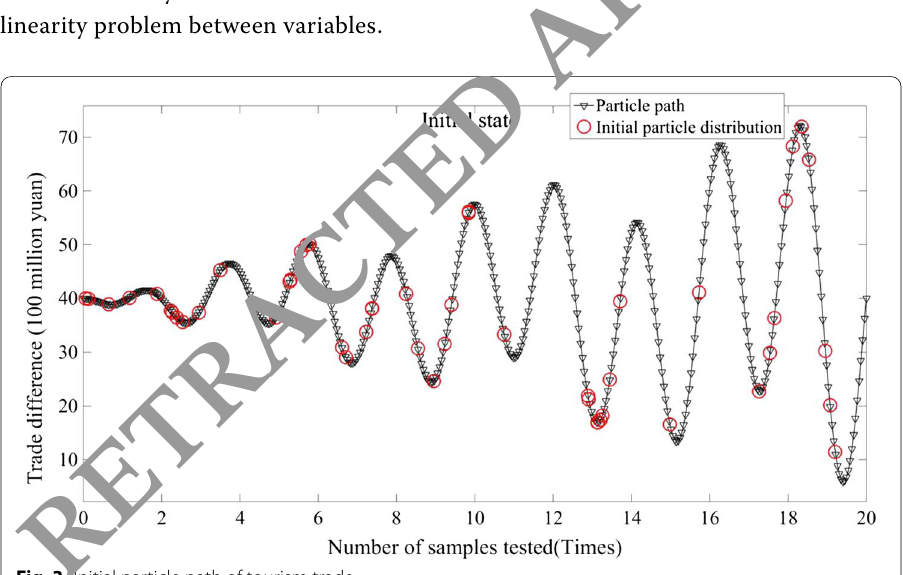
Fig. 3 Initial particle path of tourism trade